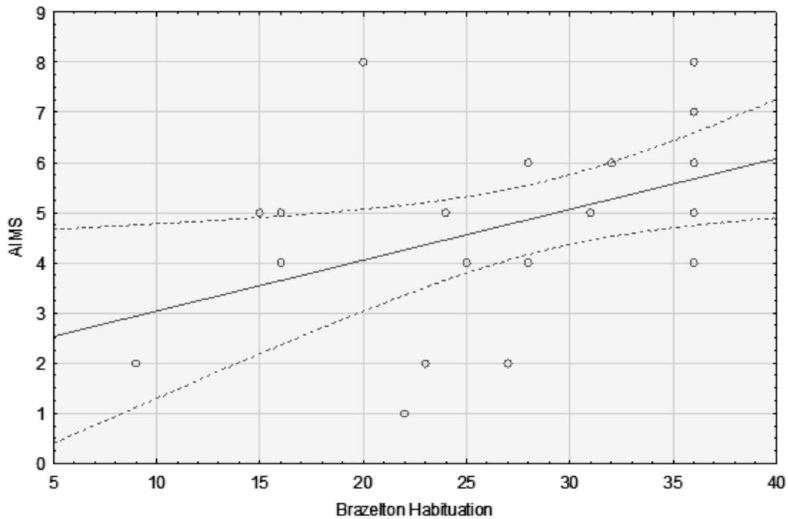
Figure 2. The Alberta Infant Motor Scale versus the Neonatal Behavioural Assessment Scale